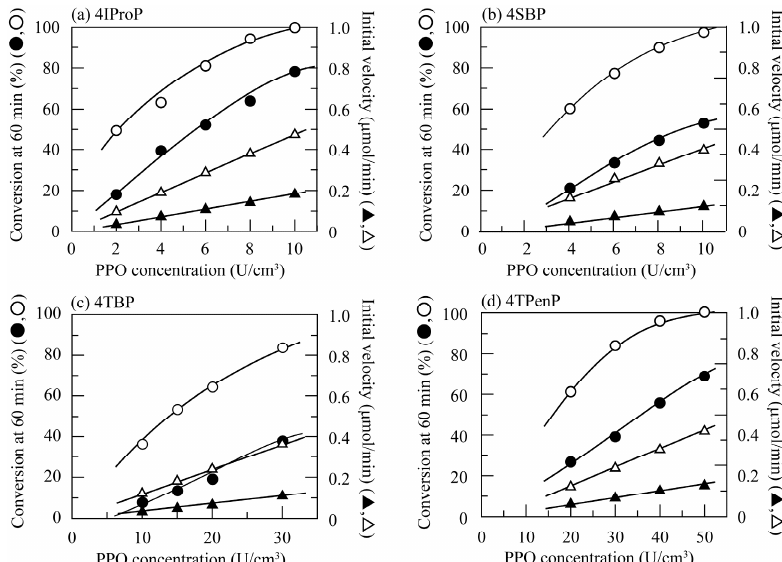
Figure 2. Changes in the conversion percent value at 60 min (circle) and the initial velocity (triangle) with the PPO concentration for PPO-catalyzed quinone oxidation of ( a ) 4IProP, ( b ) 4SBP, ( c ) 4TBP, and ( d ) 4TPenP at pH 7.0 and 40 °C in the presence (open) or absence (shaded) of chitosan beads at 0.10 cm 3 /cm 3 .